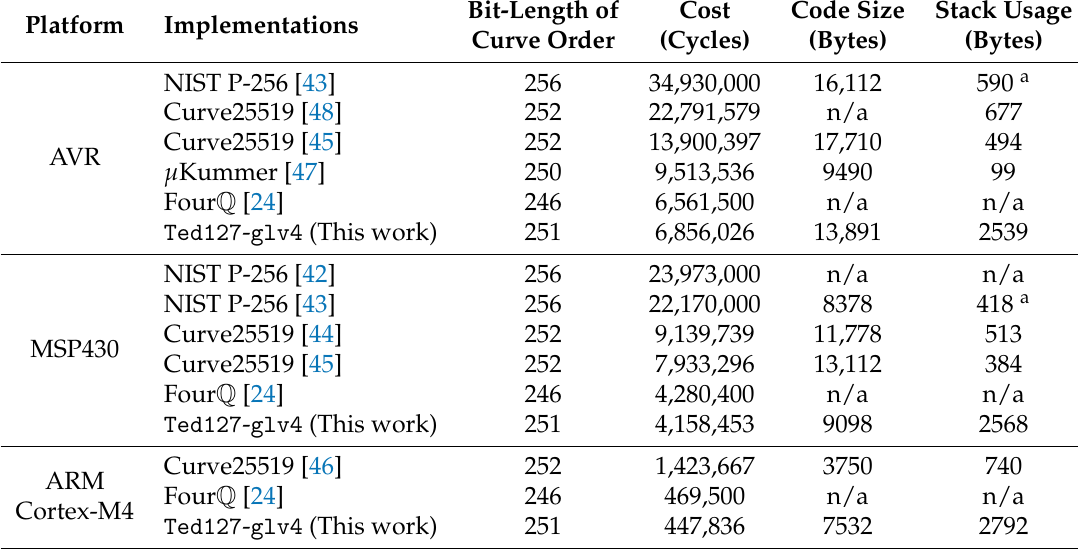
Table 4. Cycle counts and memory usage of variable-base scalar multiplication on 8-bit AVR, 16-bit MSP430, 32-bit ARM